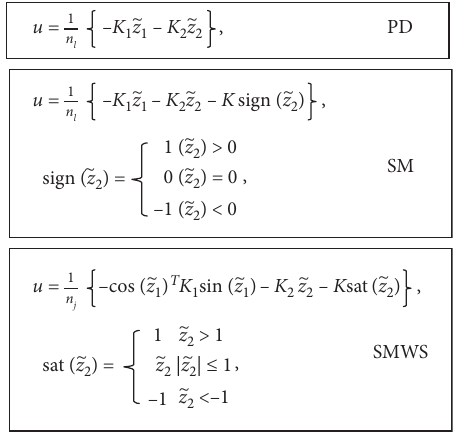
Figure 3: Relation between PD, SM, and